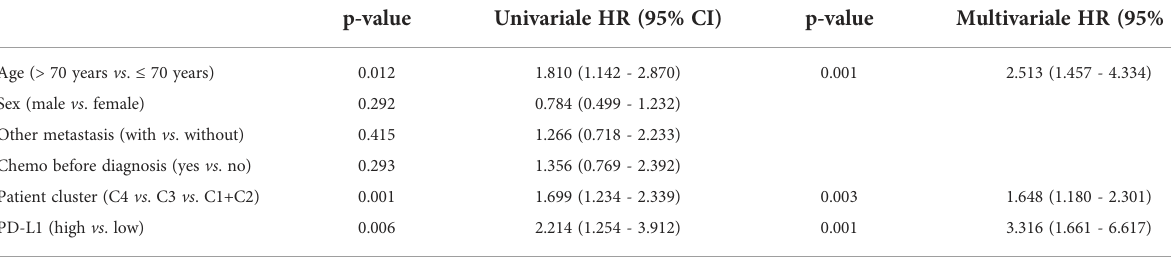
TABLE 2 Univariable and multivariable Cox regression analysis of prognostic